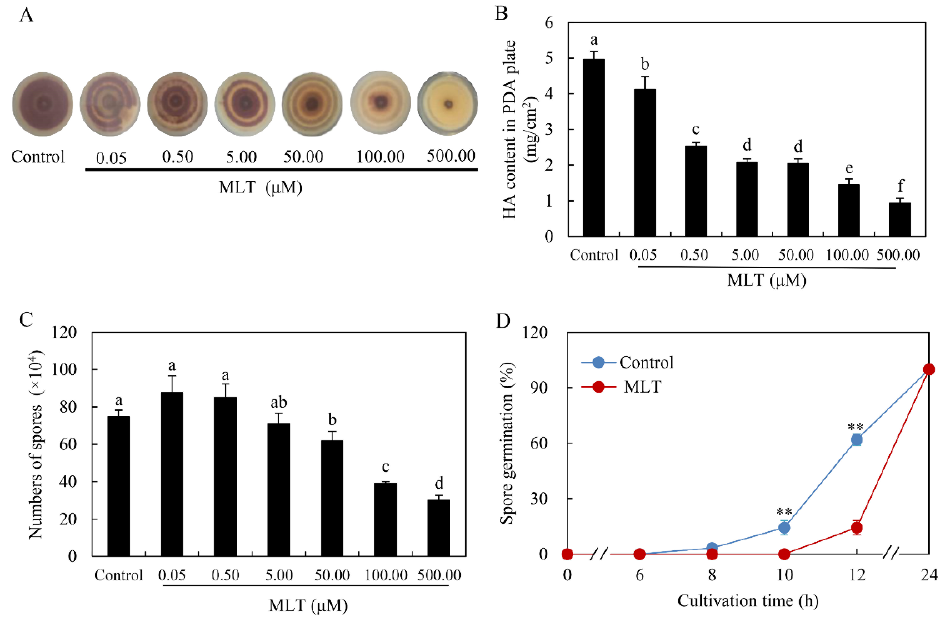
Figure 1. The effects of melatonin (MLT) on growth and HA production of Shiraia sp. S9 in solid culture. ( A ) Fungal colony in the PDA plates with MLT at 0.05–500.00 μ M. The culture was maintained at 28 °C for 8 days under light/dark shift (24 h:24 h). HA content ( B ) and the number of spores ( C ) in the PDA plate after MLT treatment. Values are mean ± SD from three independent experiments. Different letters above the bars mean significant differences ( p < 0.05). ( D ) Effect of MLT at 100 μ M on fungal spore germination. Values are mean ± SD from three independent experiments (** p < 0.01 vs. control).